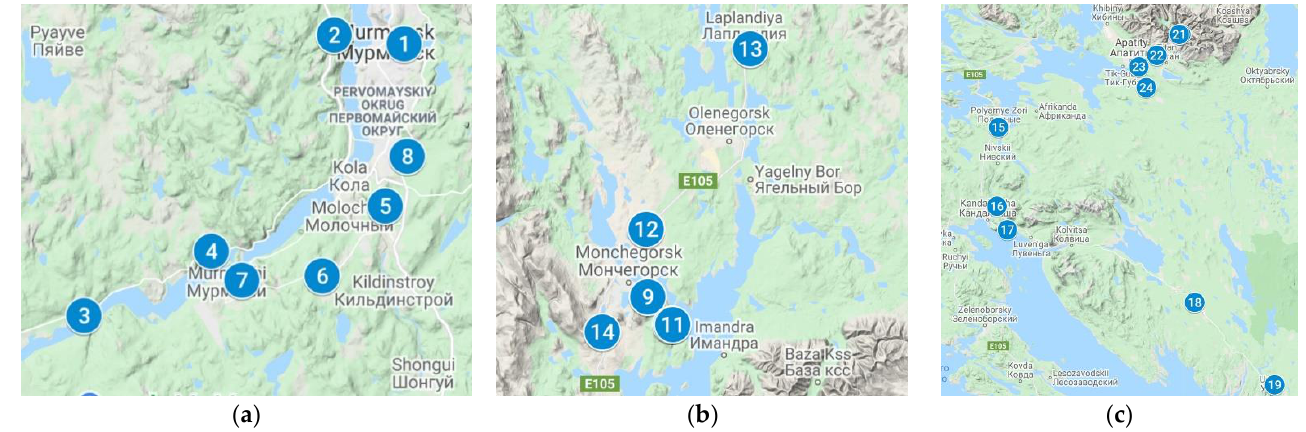
Figure 2. Sampling points. ( a ) Murmansk and Kola district; ( b ) Monchegorsk district; ( c ) Kandalaksha district and Apatity-Kirovsk district.